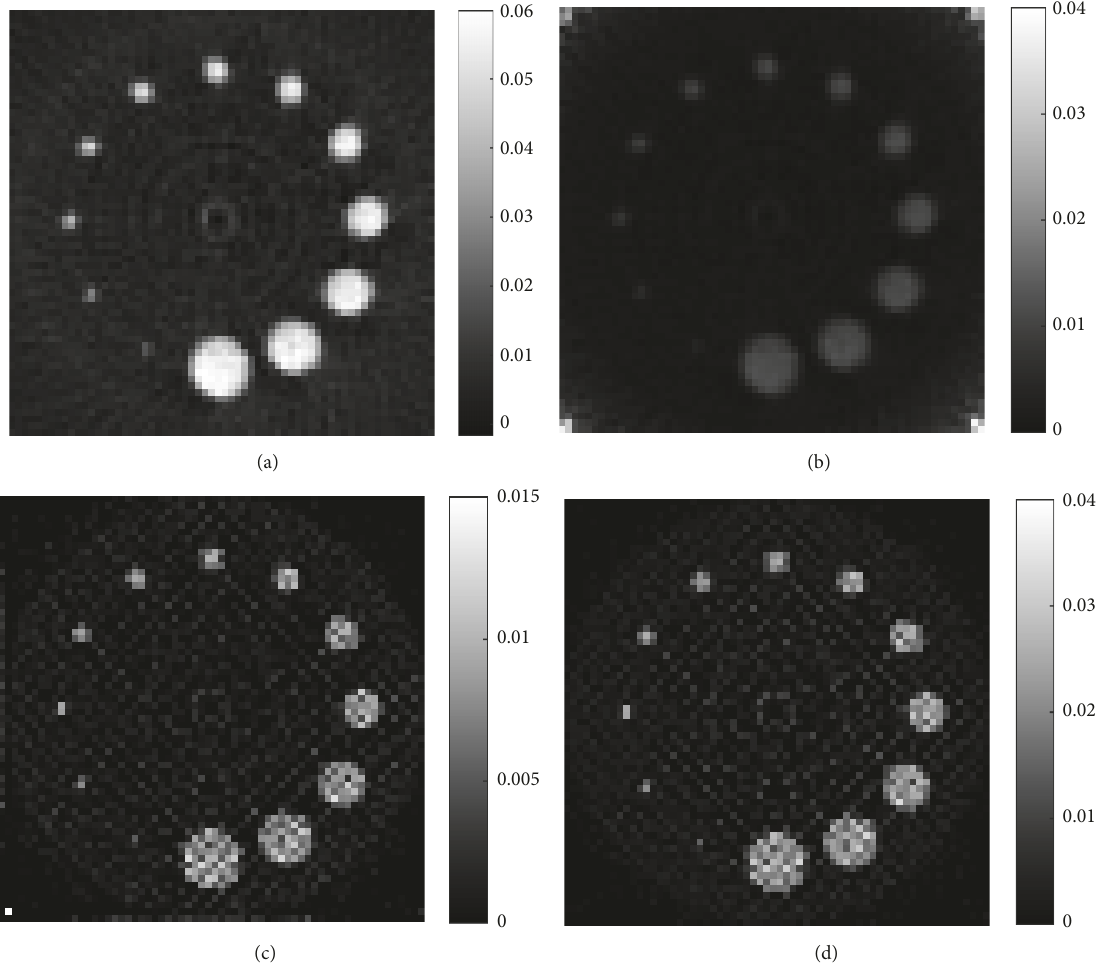
Figure9:ReconstructedXFCTimagesofphantom 𝐵 .(a)ReconstructedbyFBPwithoutcorrection,(b)reconstructedbyFBPwithcorrection, (c) reconstructed by MLEM without correction, and (d) reconstructed by MLEM with